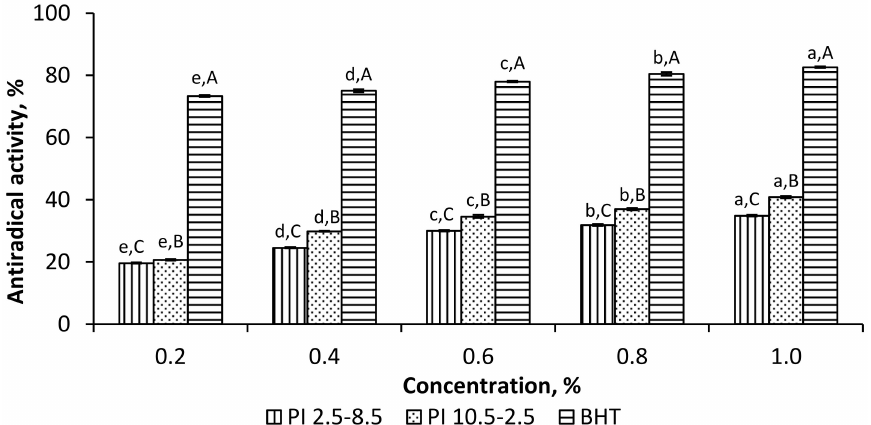
Figure 3. Scavenging effect of ethanol-treated rapeseed meal protein isolates, PI 2.5–8.5 and PI 10.5–2.5 , on 2,2-diphenyl-1-picryl hydrazyl (DPPH) radical. a–e Means of one sample with different concentrations without a common letter differ significantly ( p < 0.05). A–C Means of the samples with the same concentration without a common letter differ significantly ( p <